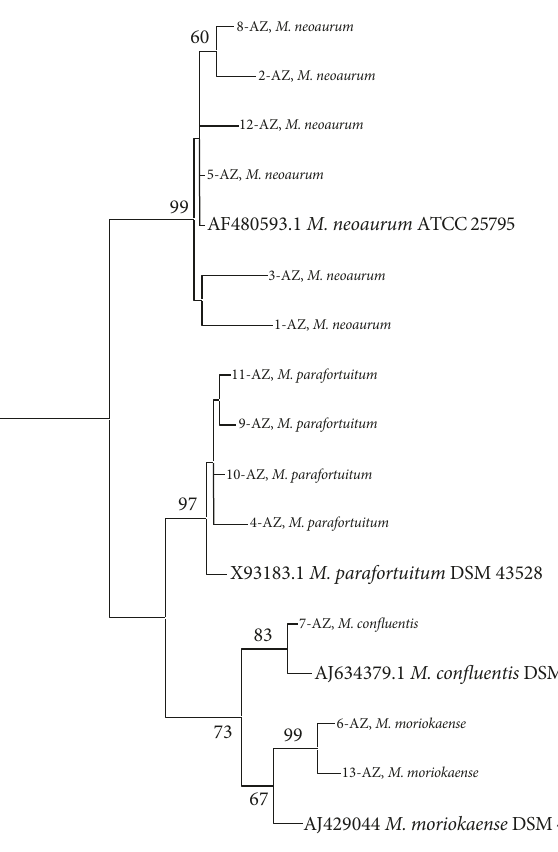
patients with urinary infections [37], meningoencephalitis and alterations in the central nervous system [38], bacteremia and endocarditis [39], and pulmonary infection [40,